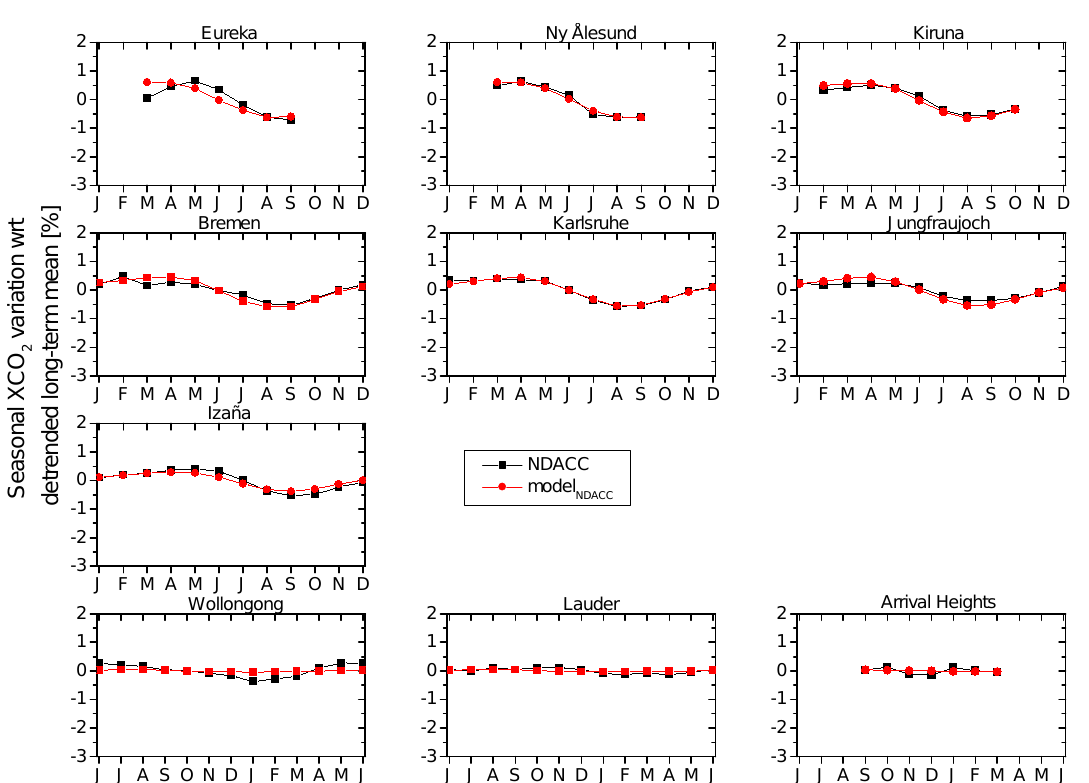
Figure A2. As Fig. A1, but now only NDACC and the damped model (model NDACC ) are compared.